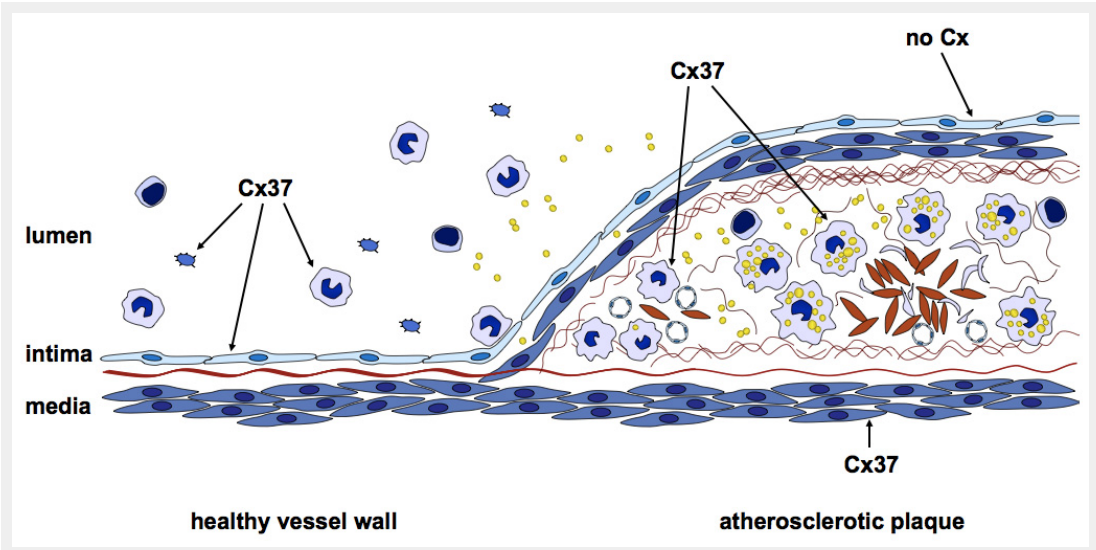
Figure 2 Connexins are differentially expressed during atherosclerotic plaque development. In the healthy vessel wall (left), Cx37 is expressed by ECs and monocytes. In contrast, at the site of an atherosclerotic plaque (right), Cx37 is expressed by VSMCs and macrophages and is no longer expressed by the endothelium overlaying the